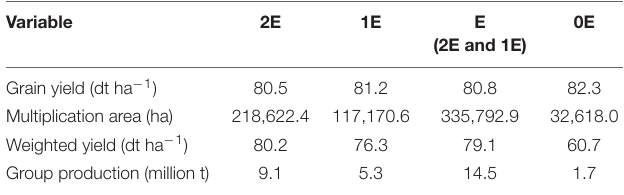
TABLE 2 | Overview of groups’ yearly averages per variable from production year 1972 to